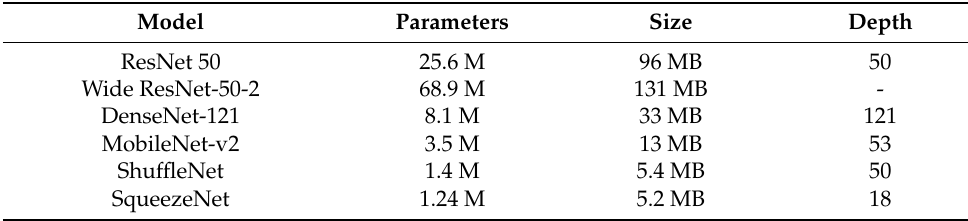
Table 1. A summary of deployed pre-trained convolutional neural